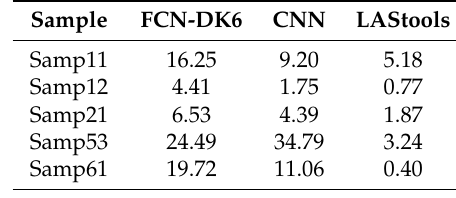
Table 4. Type-II error on ISPRS dataset.